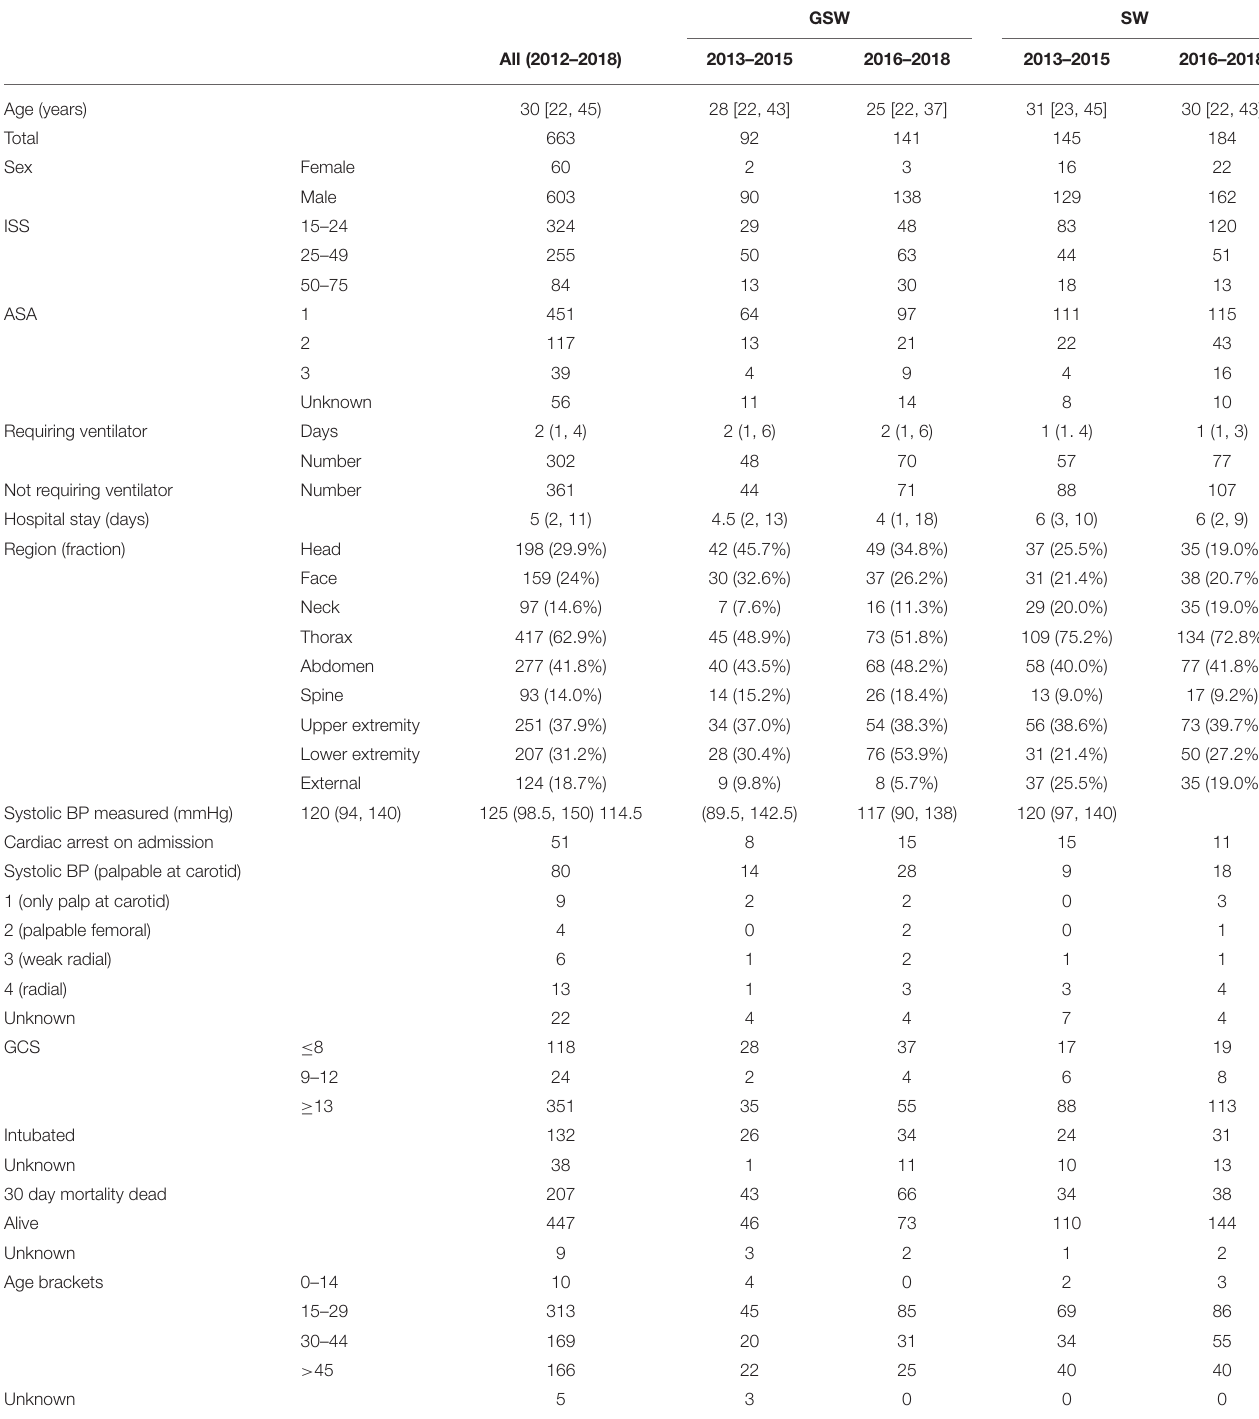
TABLE 1 | Characteristics of the